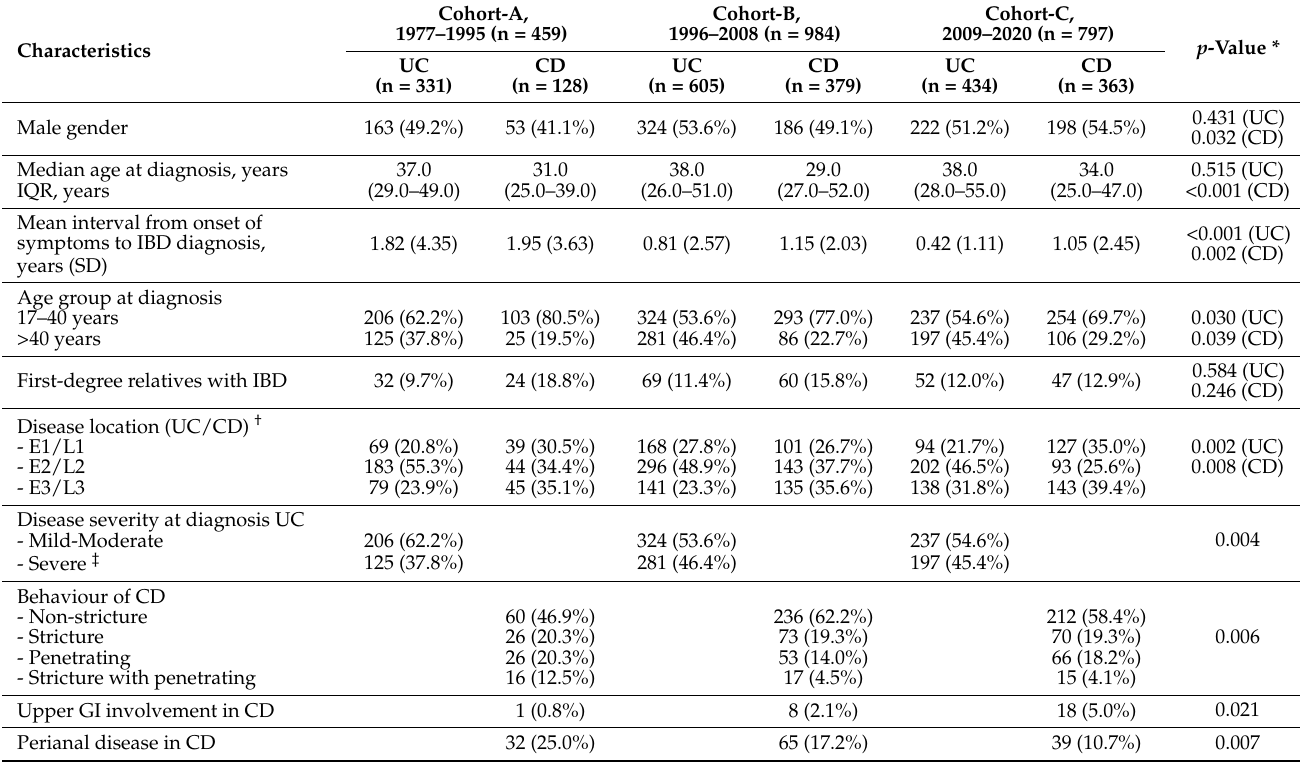
Table 1. Demographic and clinical characteristics of 2240 incident IBD patients stratified by era of diagnosis (cohort A vs. cohort B vs. cohort C) and by type of disease (UC vs.